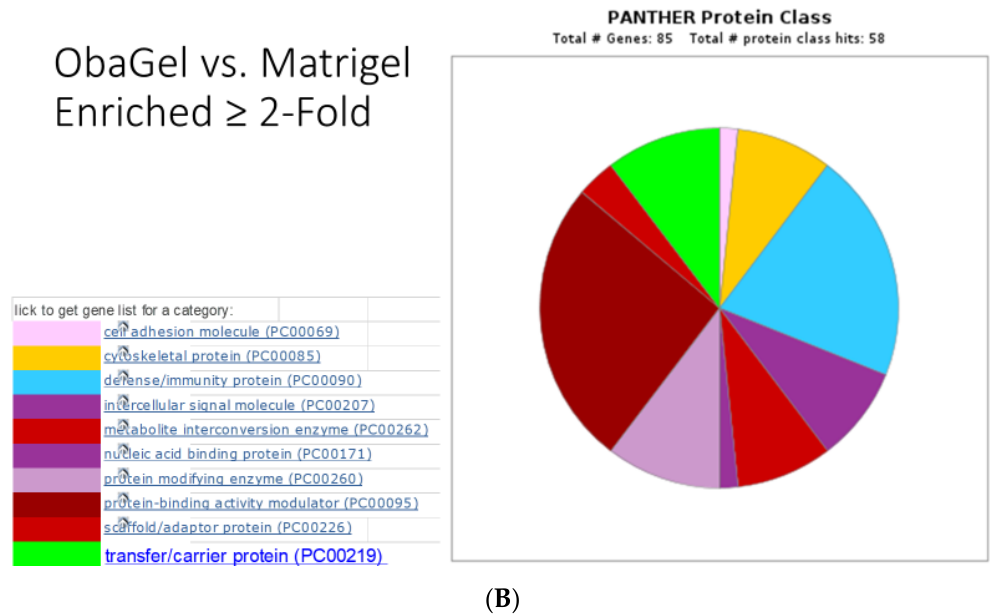
Figure 2. PANTHER pathway analysis of ObaGel vs. Matrigel proteomes based on ( A ) > 2-fold-enriched and ( B ) > 2-fold-depleted proteins. The relative abundance of proteins in representative ObaGel and Matrigel lots was determined using TMT (Tandem Mass Tag) isobaric mass tagging using tandem mass spectrometry. Those proteins enriched > 2-fold ( A ) or depleted > 2-fold ( B ) between ObaGel and Matrigel were evaluated using PANTHER pathway analyses and plotted using a pie chart.